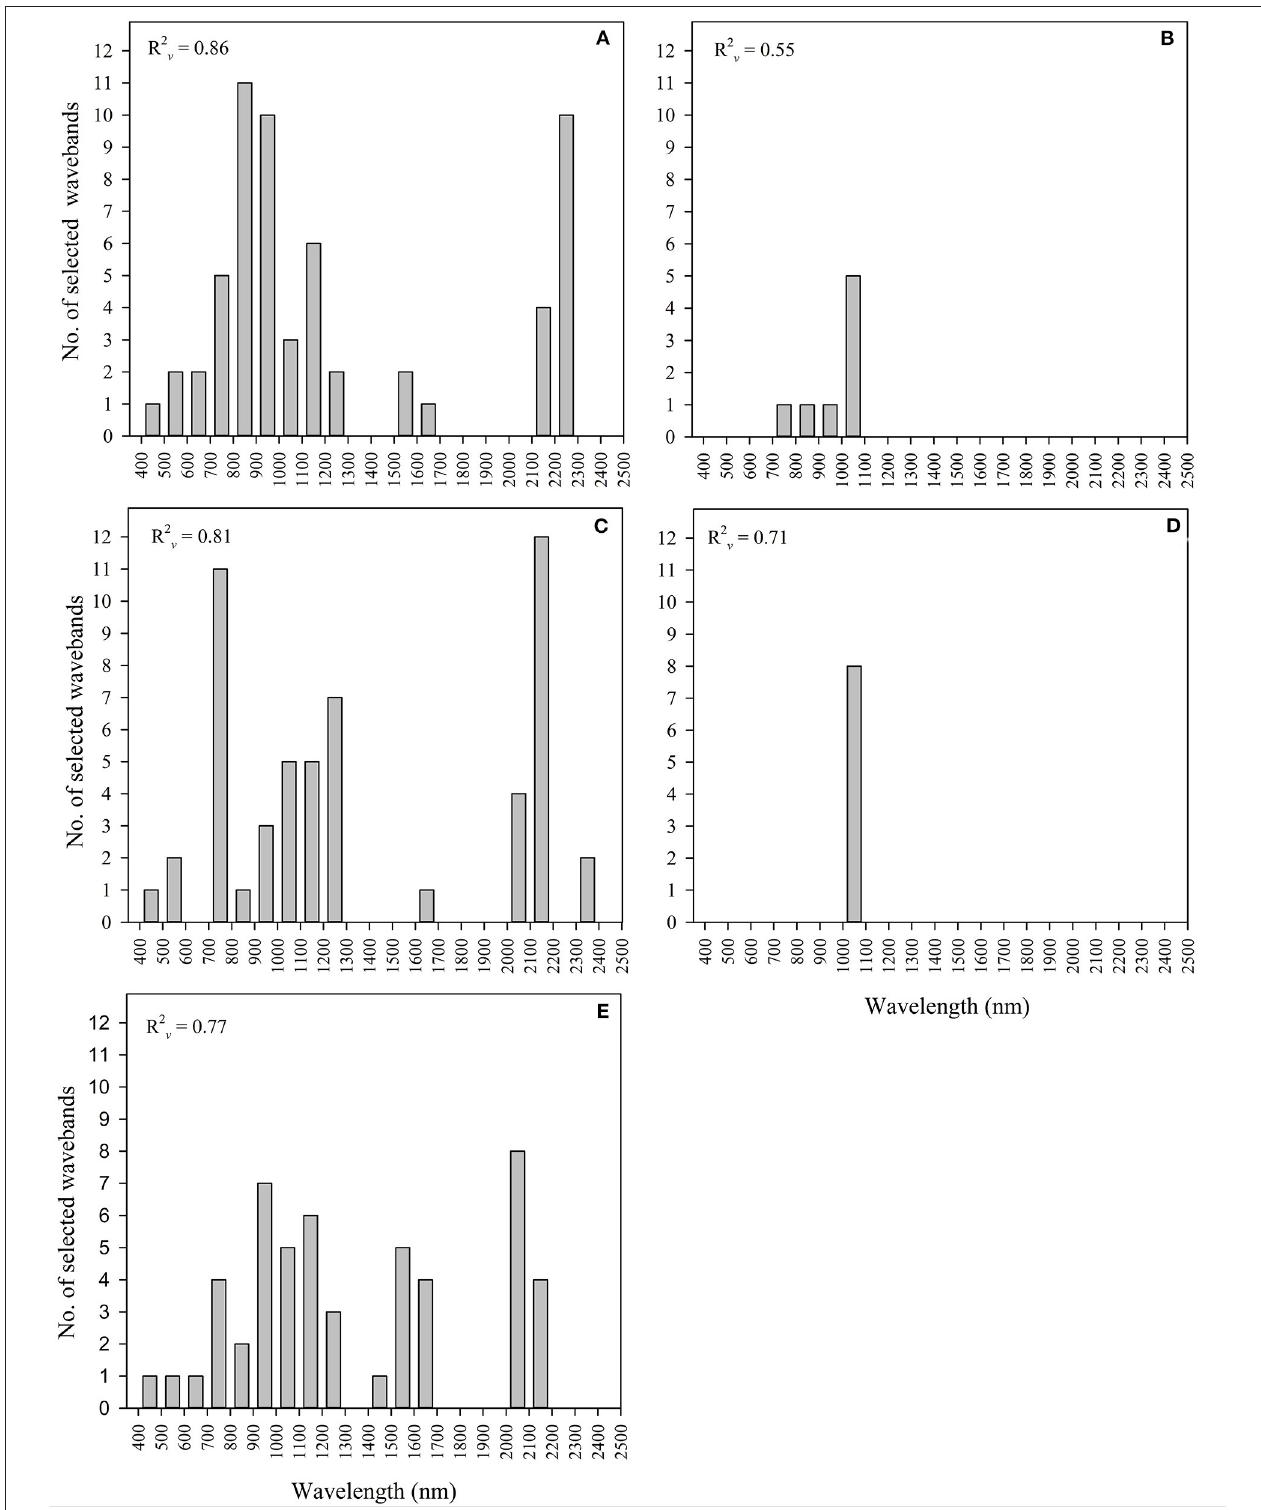
FIGURE 3 | Frequency of optimal wavebands selected across 350-2500nm spectral wavelength for (A) canopy height, (B) leaf area index (LAI), (C) canopy cover, (D) dry biomass and (E) N concentration of finger millet, using the partial least square regression (PLSR) based procedure for waveband selection.